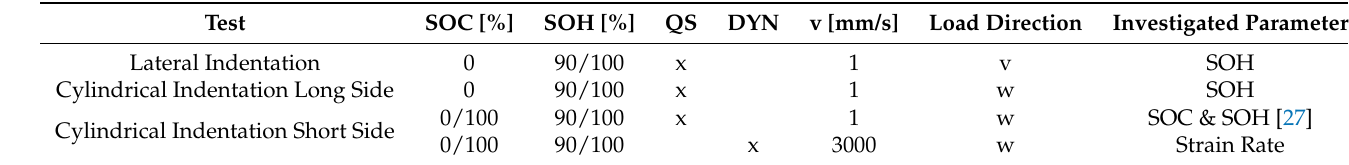
Table 1. Quasistatic (QS) and dynamic (DYN) mechanical tests for the characterization of the investigated lithium-ion pouch cell.